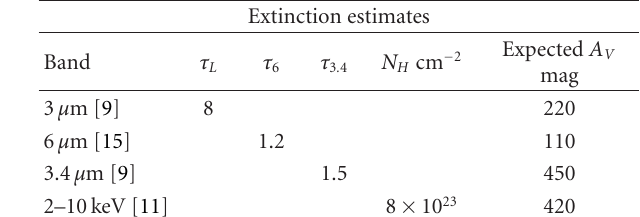
Table 2: Extinction obtained by assuming a gas-to-dust ratio as in (1). Columns: (1) observational band used for the direct mea- surement with the relative reference. (2) and (3) L -band and 6 μ m optical depth for the AGN continuum as obtained with our spectral decomposition model. (4) Optical depth of the aliphatic hydrocar- bon feature once corrected for the SB dilution. (5) Gas column den- sity measured from the X-ray spectrum. (6) Optical extinction pre- dicted by Galactic relations (see text for